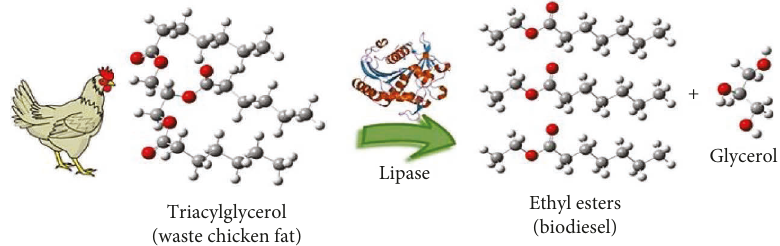
Figure 1: Transesterification reaction of chicken fatty acids by